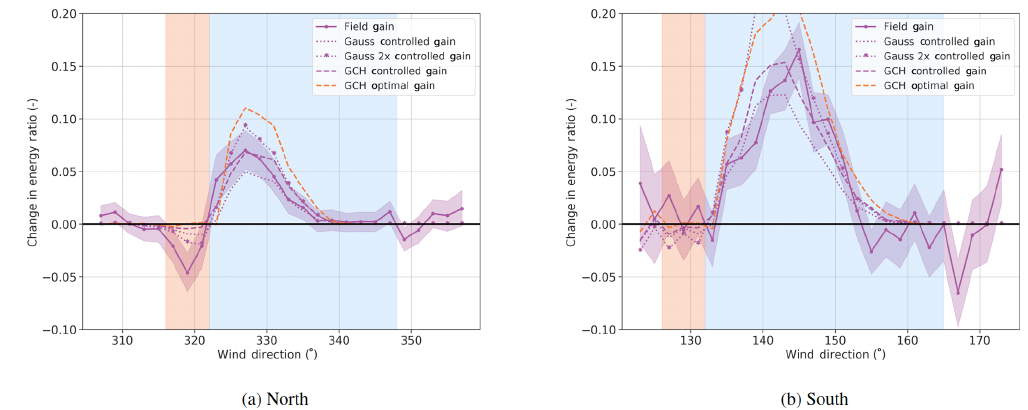
Figure 8. Change in energy ratio for the downstream turbine (T3) with respect to the reference. FLORIS results include “controlled” gain, which simulates the results in FLORIS using the measured offsets from the field campaign for each model, whereas the “optimal” gain is computed using the targeted offsets for GCH